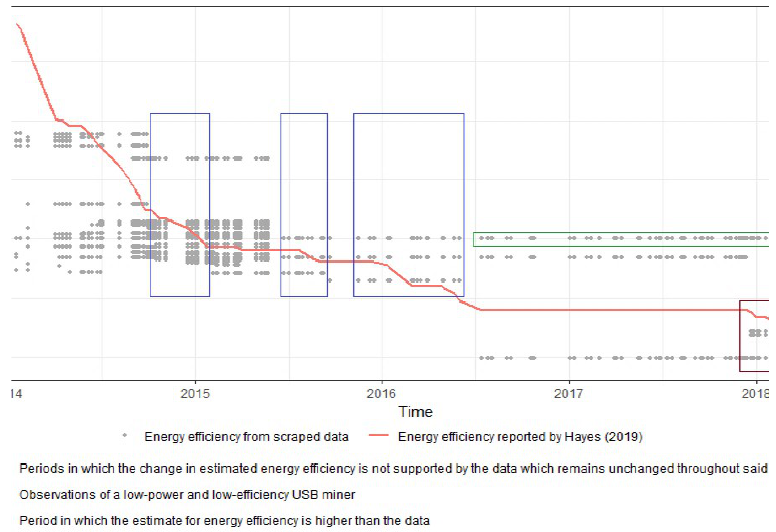
Figure 2. Energy efficiency of ASIC data scraped from the “Mining hardware comparison” webpage, and the network energy efficiency reported by Hayes (2019). Logarithmic